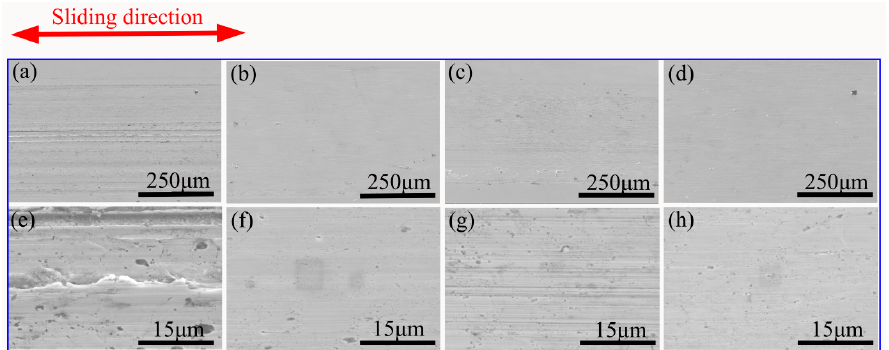
Figure 12. The wear surfaces of four composites tested under the load of 15 N: ( a , e ) 0 wt.% HEA; ( b , f ) 5 wt.% HEA; ( c , g ) 10 wt.% HEA; and, ( d , h ) 15 wt.% HEA,